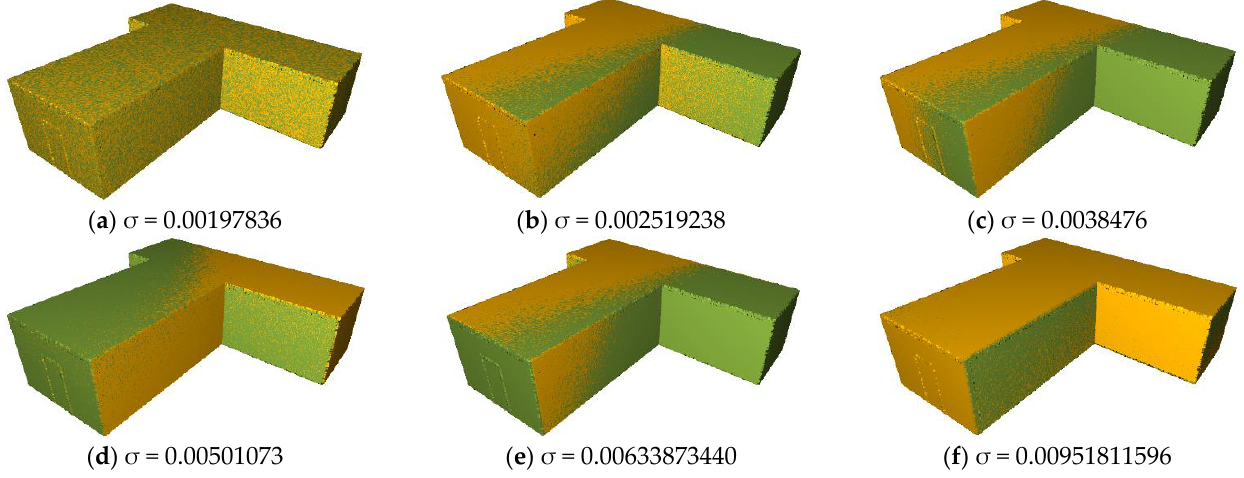
Figure 12. Visualization of as-built (yellow) and as-planned (green) registered according to the different transformation parameters with respective error values in ascending order ( a – f ).